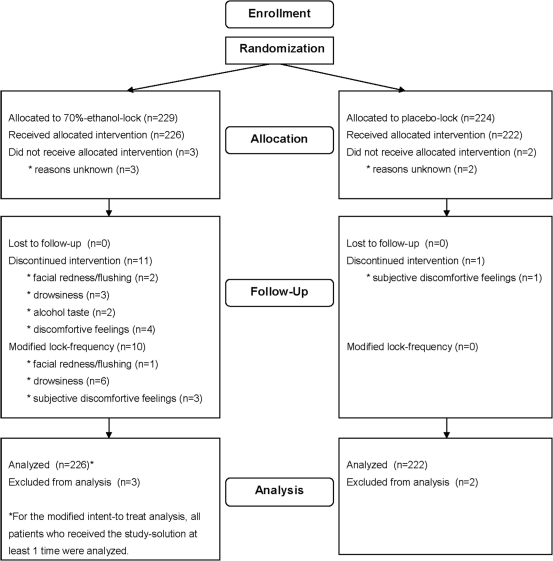
Flow-diagram for numerical illustration of the different stages of the study.